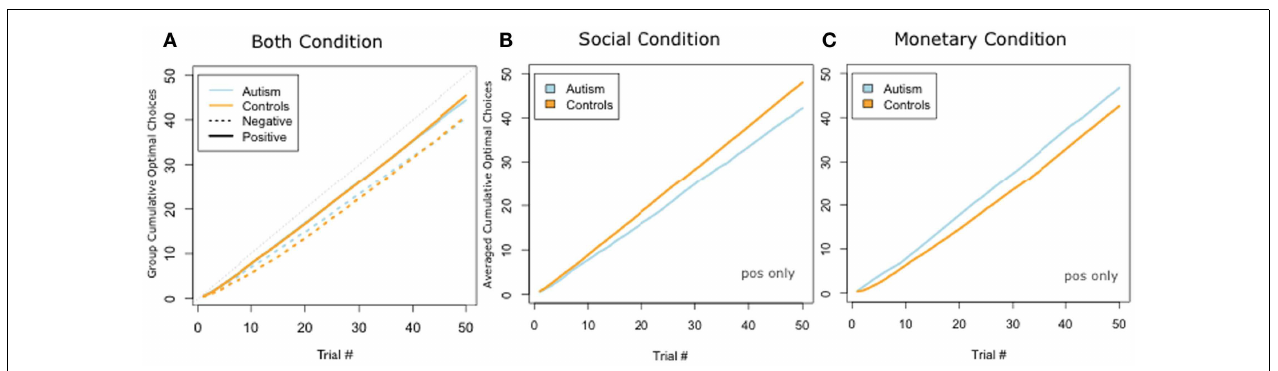
found a double dissociation, such that ASD participants cumulatively made a greater number of optimal choices in the monetary condition, whereas controls cumulatively made a greater number of optimal choices in the social